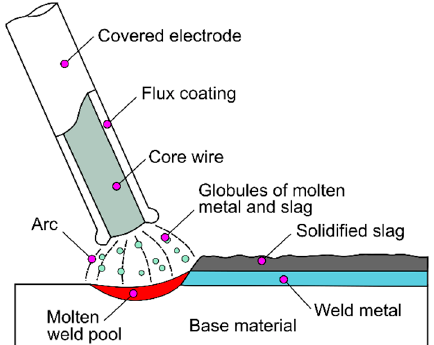
Figure 1. The idea of manual metal arc (MMA) welding.